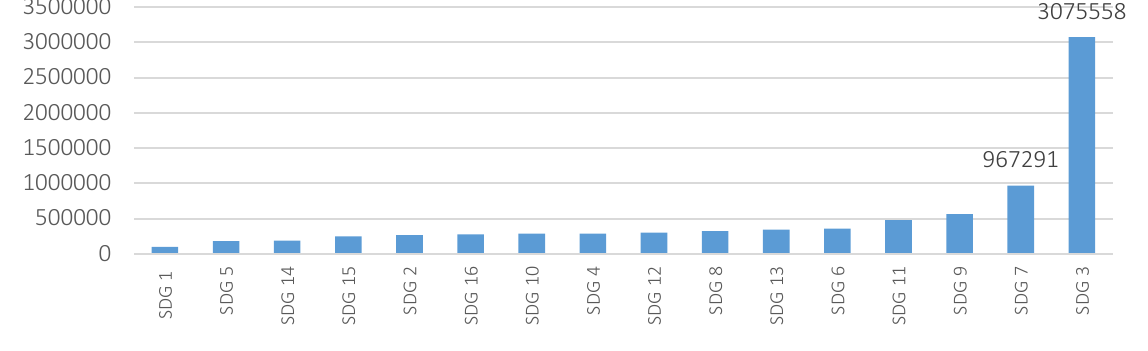
Figure 1. SDG-related papers in SciVal in 2017–2022